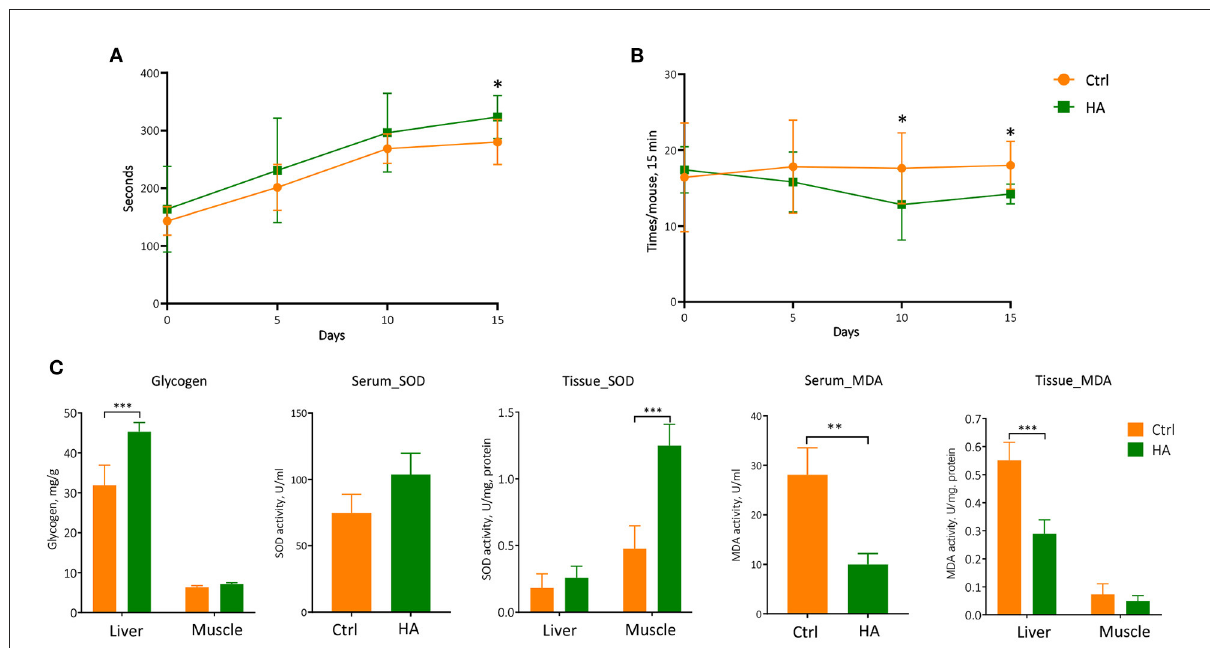
FIGURE4 The anti-fatigue property of HA. (A) The retention time on the rotarod of the mice from three consecutive attempts. (B) The times of fall of the mice within 15min. (C) The level of the glycogen, SOD, and MDA in the serum, liver, and muscle. n = 5. * p < 0.05; ** p < 0.01; *** p < 0.001.